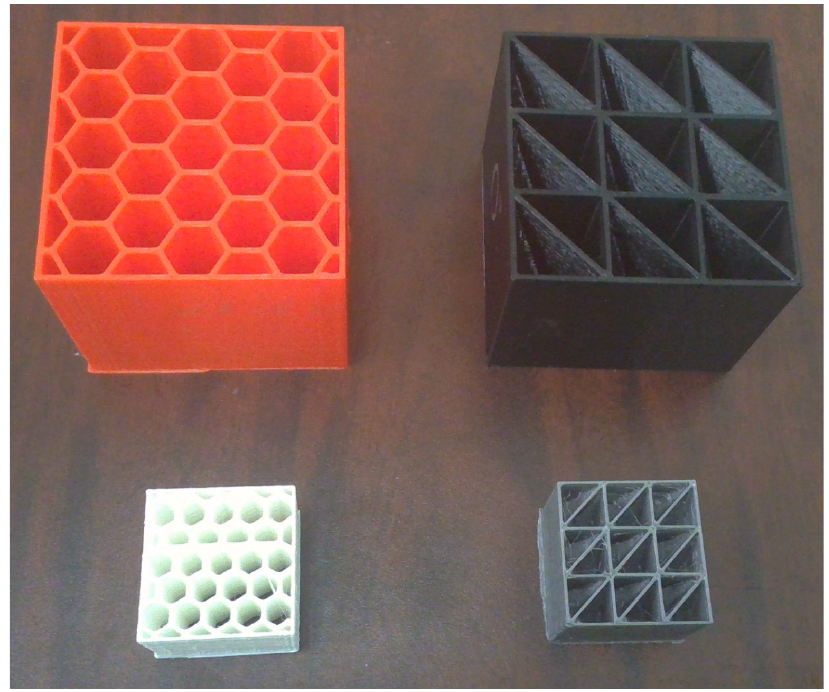
Figure 3. 3D ‐ printed PLA test specimens in regular scale and double scale: standard geometry ( left ) and innovative geometry ( right ). and innovative geometry ( right